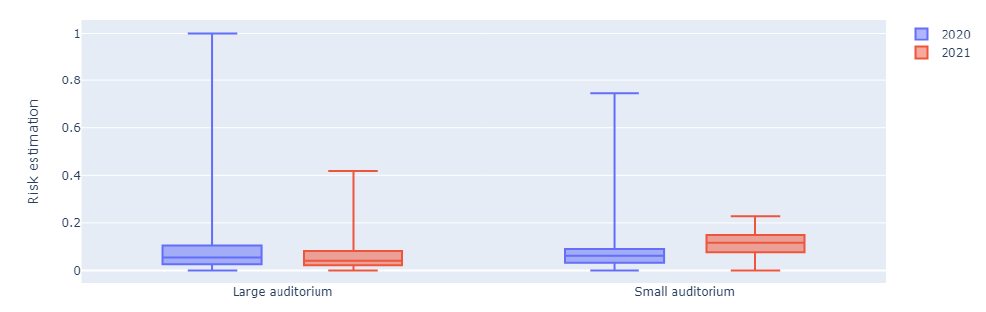
Figure 10. COVID-19 aerosol transmission risk estimation box plots of the examination periods of January 2020 and January 2021 for two auditoriums.